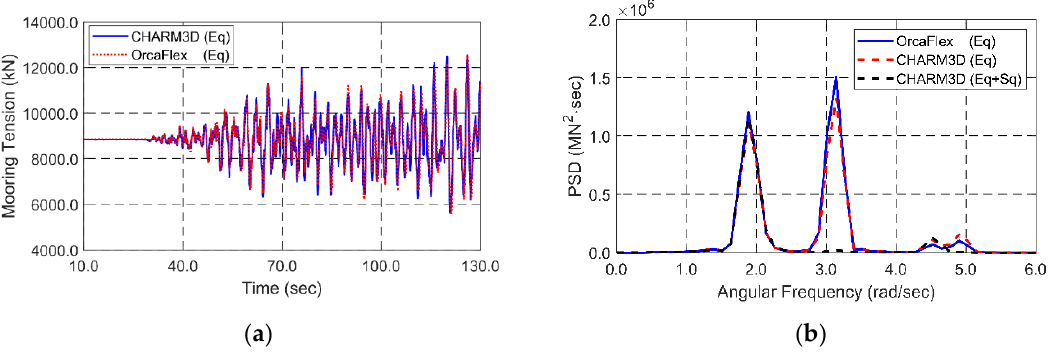
Figure 14. Time histories (without seaquake) ( a ) and spectra ( b ) of mooring tension #4 at the middle location under seismic excitations